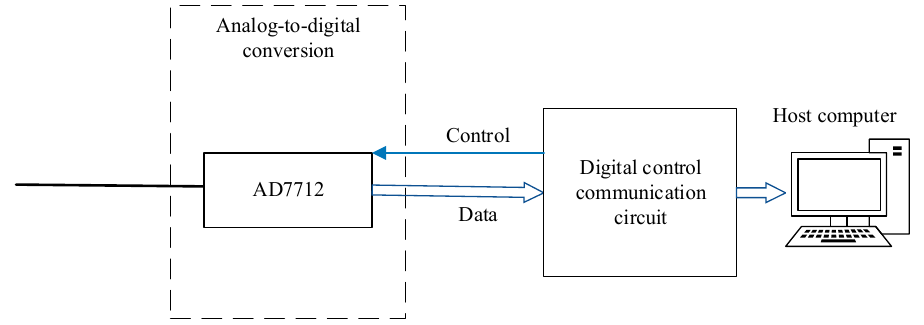
Figure 9. Working-principle diagram of analog-to-digital conversion module. The electronic design parameters of the capacitive sensing system are shown in Table 2. Table 2. Electronic design parameters of capacitive sensing system.